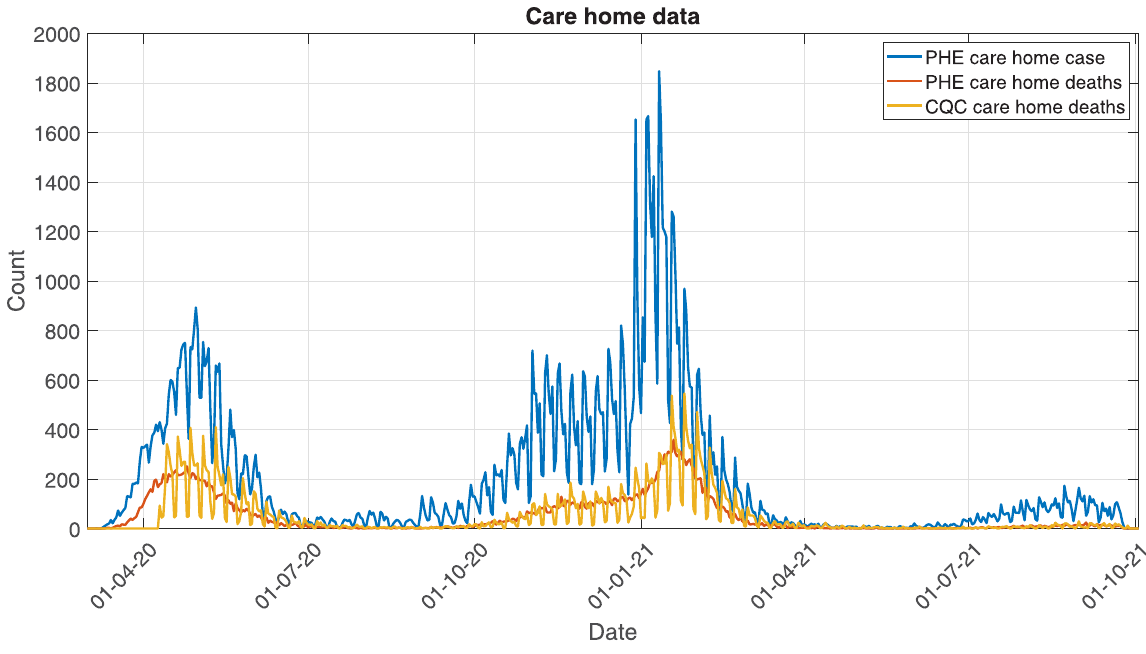
Fig 1. Plotting the time series for the 3 data streams: Cases, PHE deaths, and CQC deaths.